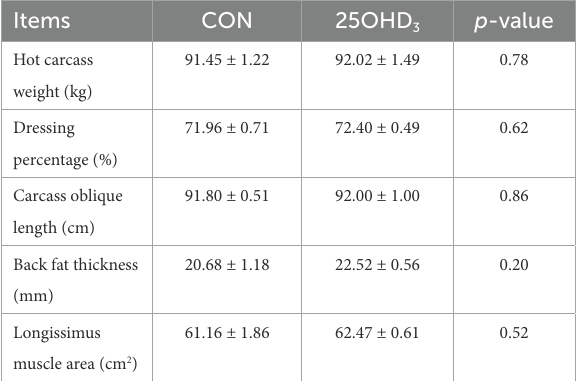
TABLE 4 Effects of 25OHD 3 supplementation on carcass traits of growing-finishing pigs.